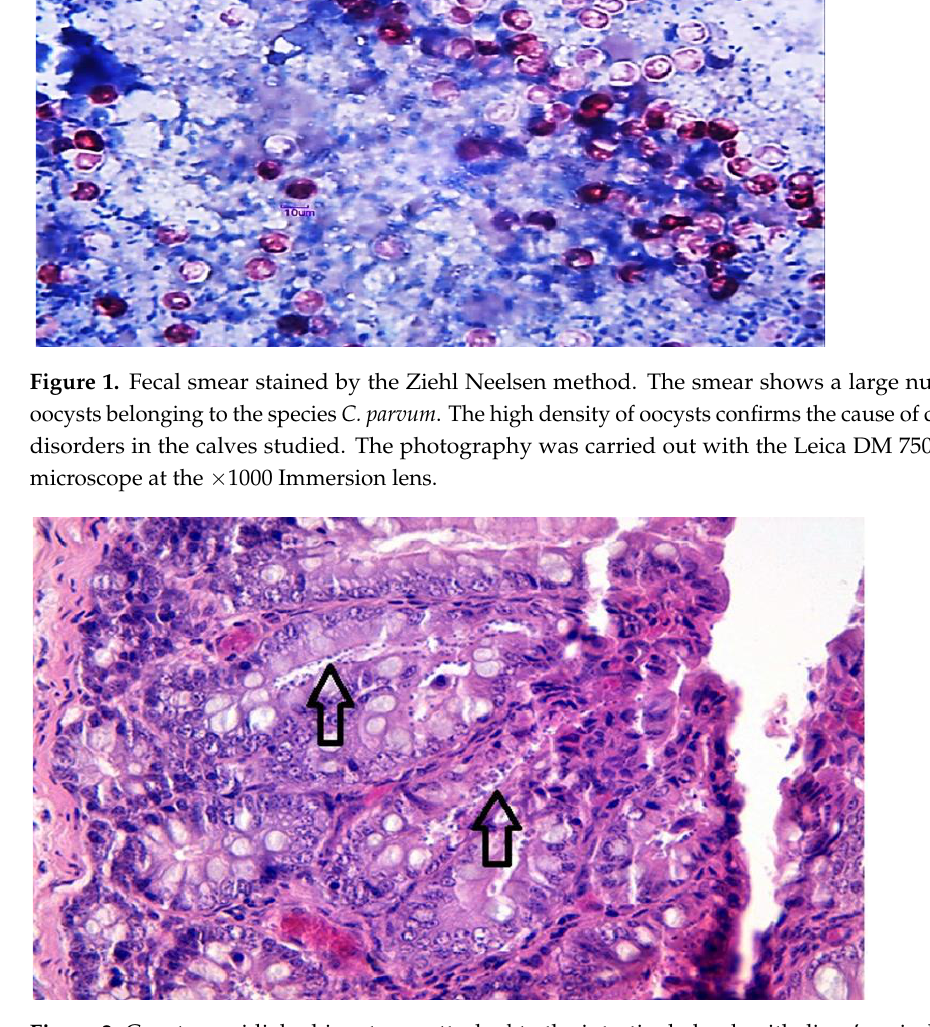
Figure 2. Cryptosporidial schizonts are attached to the intestinal gland epithelium’s apical surface (arrows). H&E 400 ×